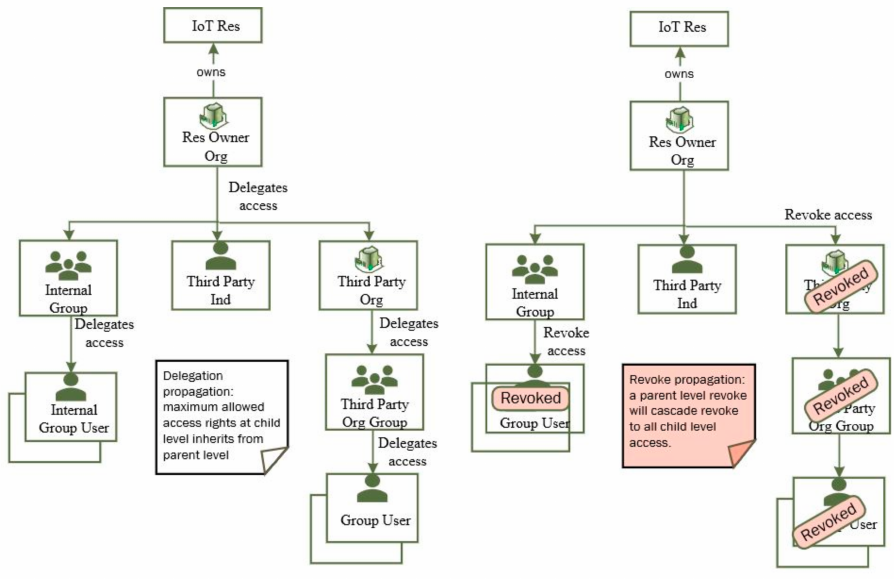
Figure 3. A seamless delegation and revoke propagation in the proposed system